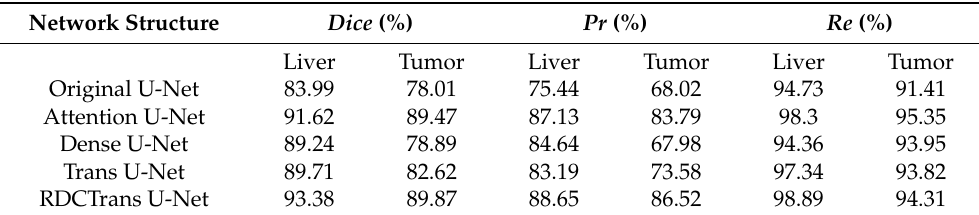
Table 2. The segmentation results of liver and tumor of each model on LiTS data